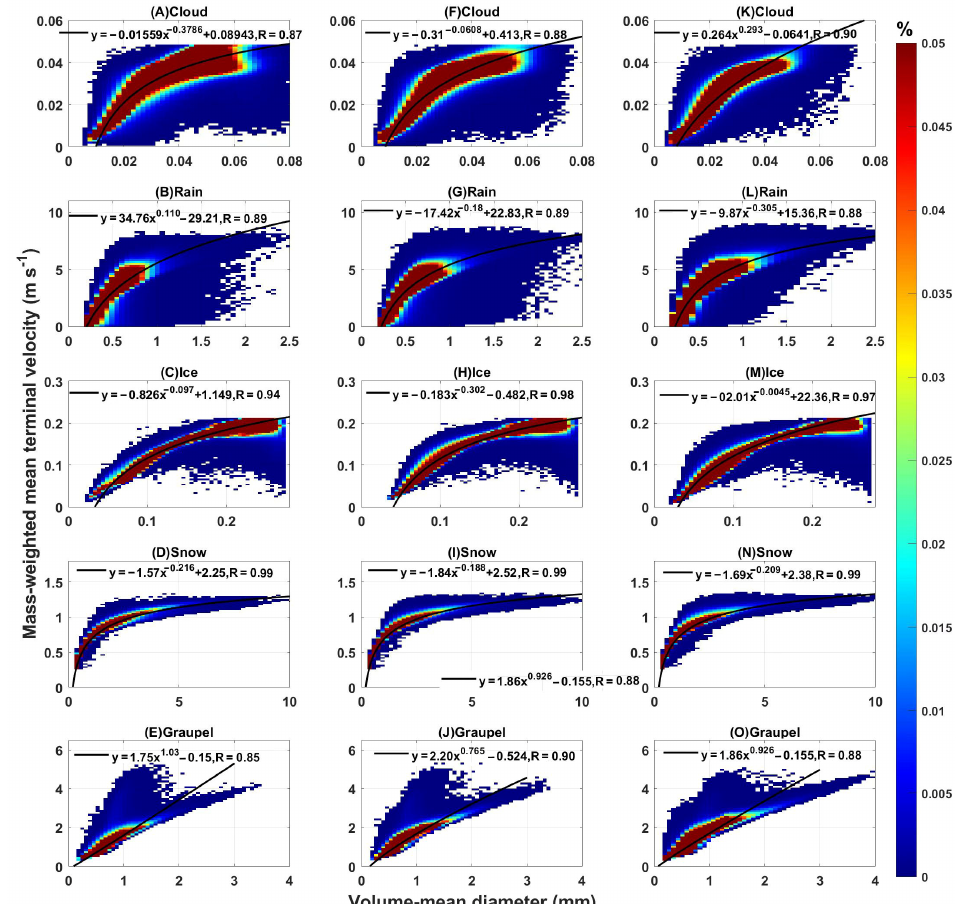
Figure 1. Joint probability density function of the relationship between mass-weighted mean terminal velocity (m s − 1 ) and volume-mean diameter (mm) based on clean (left), moderate pollution (middle), and polluted (right) conditions for different types of hydrometeors: ( A , F , K ), cloud droplets, ( B , G , L ) raindrops, ( C , H , M ) ice crystals, ( D , I , N ) snow, and ( E , J , O ) graupel particles. The black curves indicate the fitting function, and R represents the correlation coefficient. In the fitting function, x and y represent the volume-mean diameter and the mass-weighted mean terminal velocity, respectively.